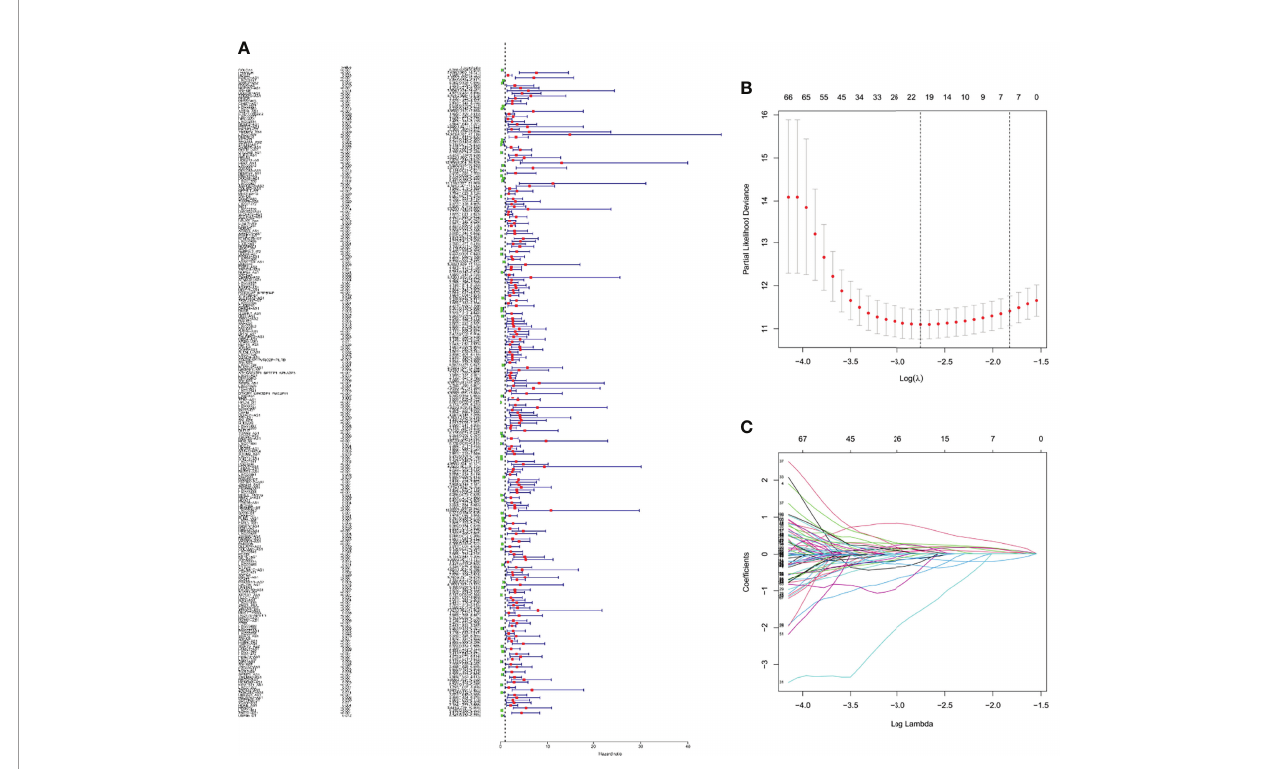
FIGURE 3 | The risk model for KIRC patients based on m6A-related lncRNAs (A) Univariate Cox regression analysis revealed that the selected lncRNAs signi fi cantly correlated with clinical prognosis. (B) The tuning parameters (log l ) of OS-related proteins were selected to cross-validate the error curve. According to the minimal criterion and 1-se criterion, perpendicular imaginary lines were drawn at the optimal value. (C) The LASSO coef fi cient pro fi le of 19 OS-related lncRNAs and perpendicular imaginary line were drawn at the value chosen by 10-fold